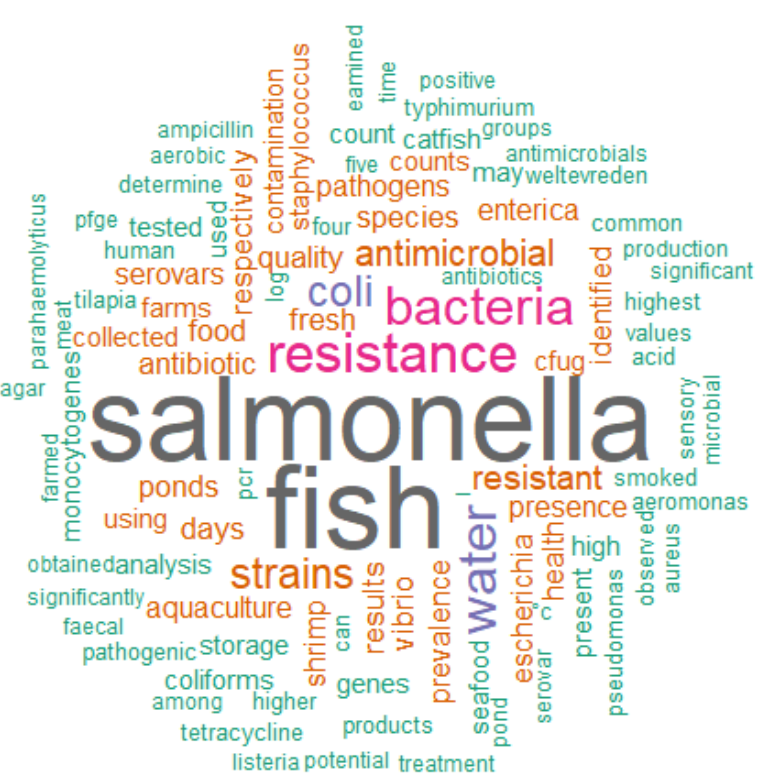
Figure 2. Word cloud formed from the abstracts of the articles selected by the integrative review on microbiological diagnoses of Salmonella spp. in aquaculture between 2000 and 2020. N total of words =